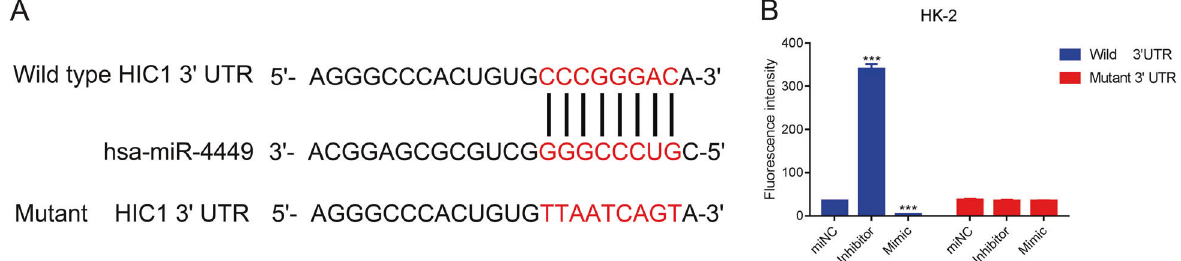
Fig. 7 miR-4449 inhibits expression of HIC1. A Sequences of wild type HIC1 3 ′ UTR (wild type), miR-4449 and HIC1 3 ′ UTR with mutations in the sequence complementary to miR-4449 (mutant) are shown. B HK-2 cells transfected with reporter dual luciferase gene with wild type or